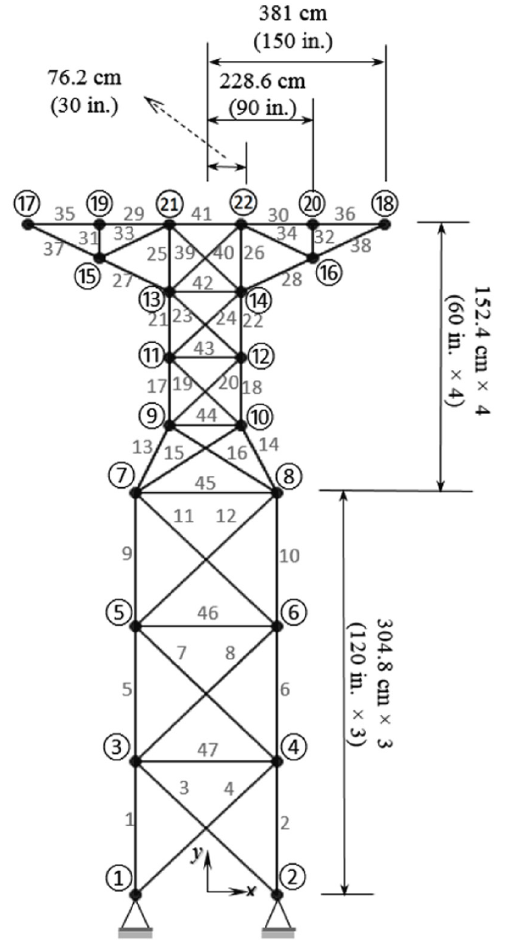
Fig. 14. Schematic of the planar 47-bar truss